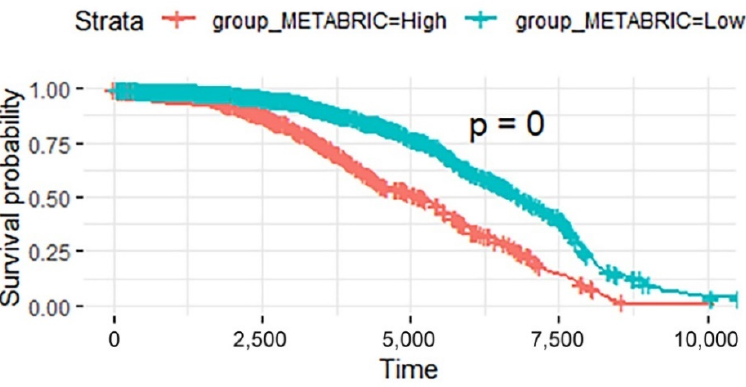
Figure 8. Kaplan-Meier curves of patients in the two risk groups dichotomized by deregulation of the prognosis pathways in BRCA data in METABRIC. The x axis shows survival in days. The y axis shows the overall survival rate.